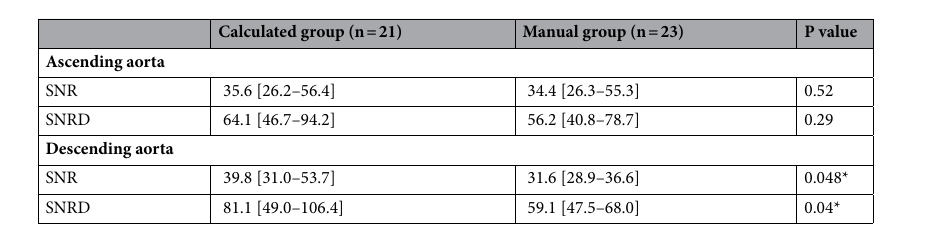
Table 2. Image quality in the aorta. The patients with Glenn shunt and Fontan circulation are excluded due to their specific methods of contrast agent administration. * indicates statistical significance. SNR signal-to-noise ratio, SNRD dose-normalized signal-to-noise